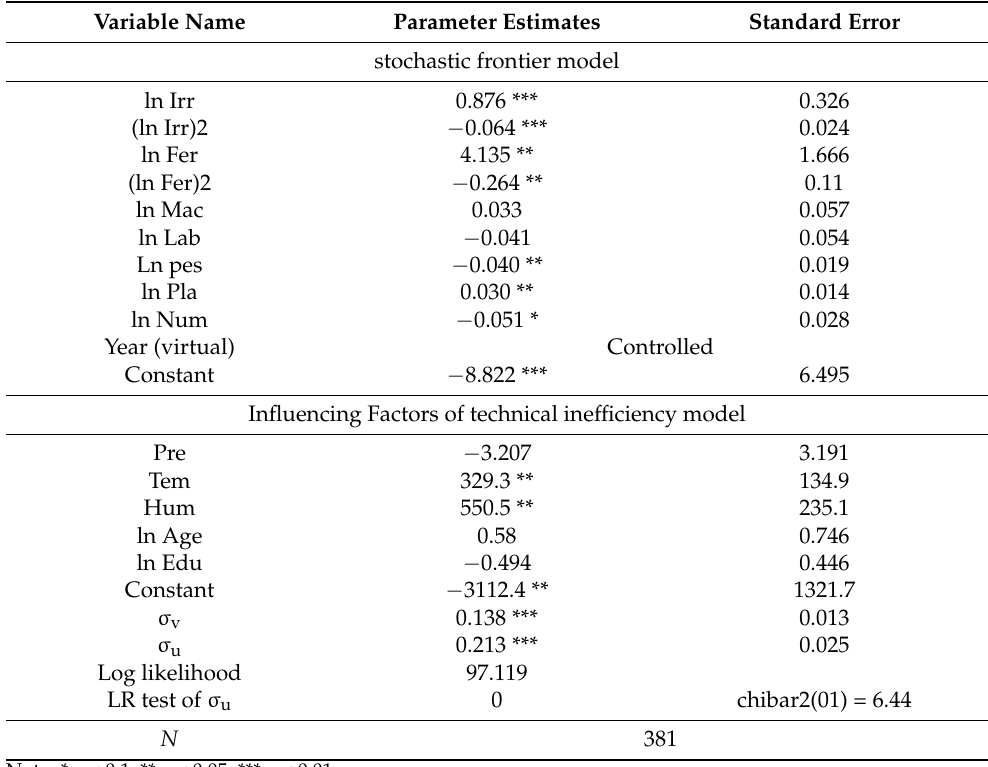
Table 3. Parametric regression results of the stochastic frontier